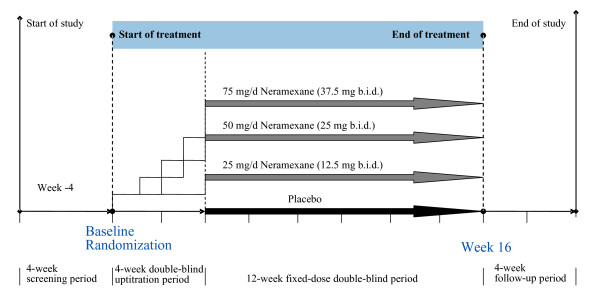
Study flow chart